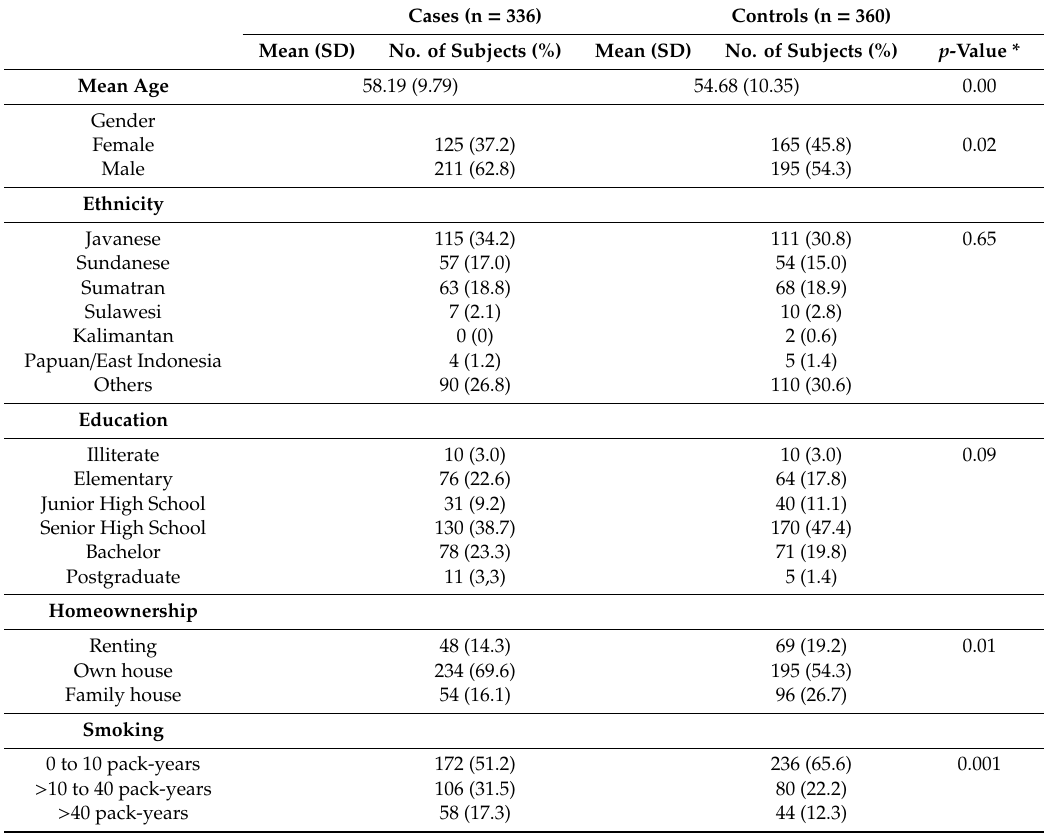
Table 1. Characteristics of